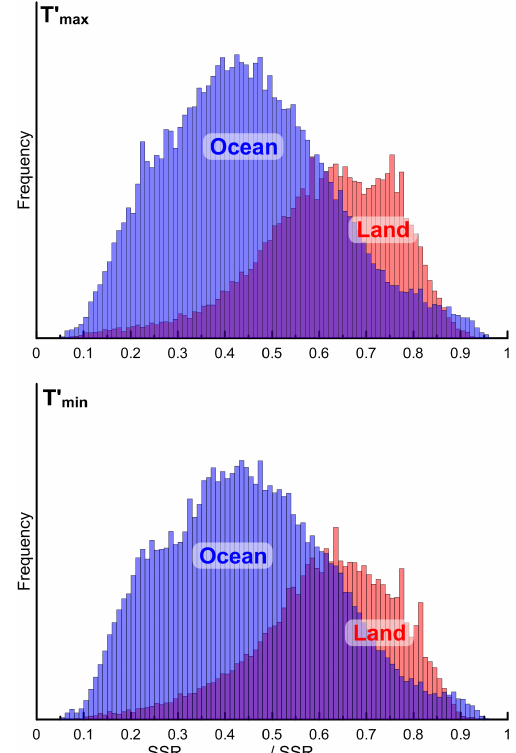
Fig. 7. Histograms of the ratios of the SSR values for the five basis functions CPSM (SSR5) to the one basis function CPSM (SSR1) for T 0 max (upper panel) and T 0 min (lower panel). The SSR ratios were determined for every grid point by dividing SSR5 by SSR1. The grid points and corresponding SSR ratios were assigned to be located over land or ocean and those values are shown in the histograms. SSR ratios shown here are based on all three RCP simulations, where the regression model has been trained separately on each RCP scenario. (which is the more traditional version of the CPSM) is used to explore the remaining methodological